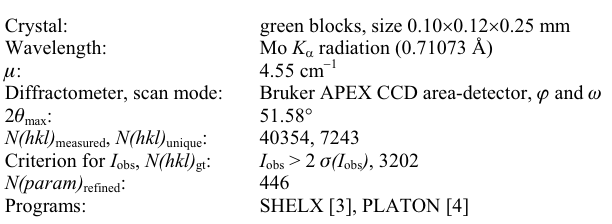
Table 1. Data collection and handling.